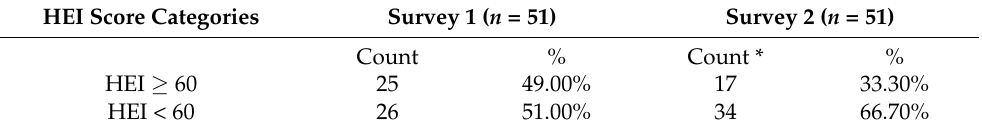
Table 6. Distribution of participants among HEI categories for surveys 1 and